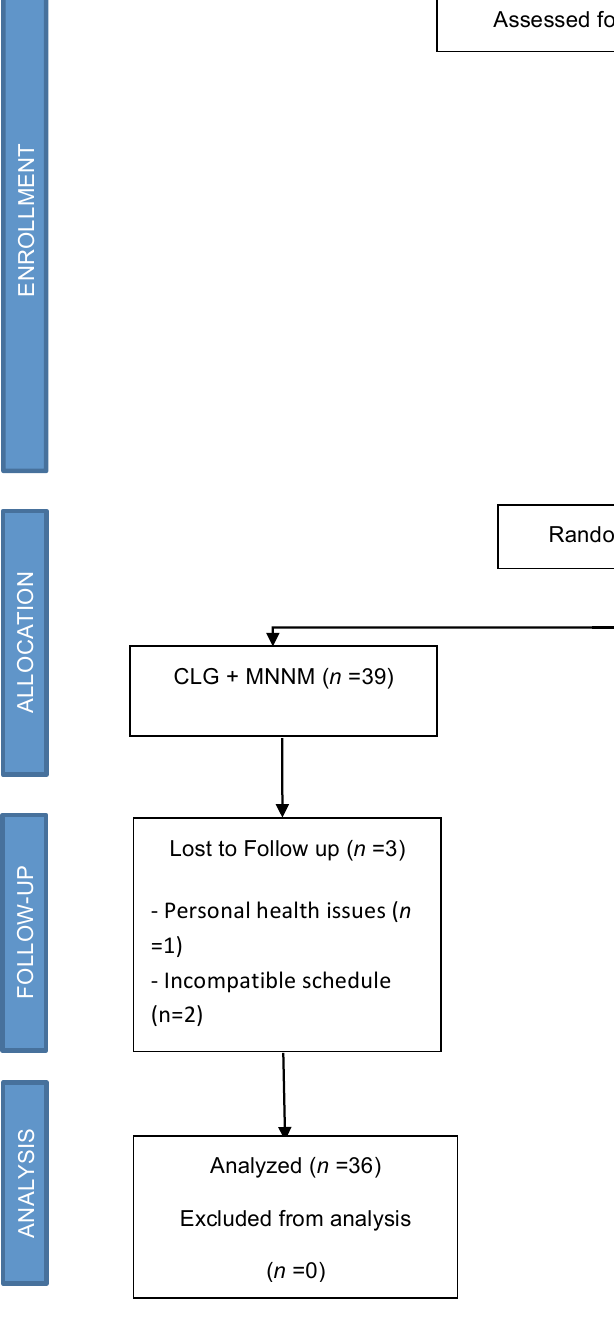
Figure 1. Consort flow diagram. CLG = cervical Lateral Glide; MNNM = median nerve neural